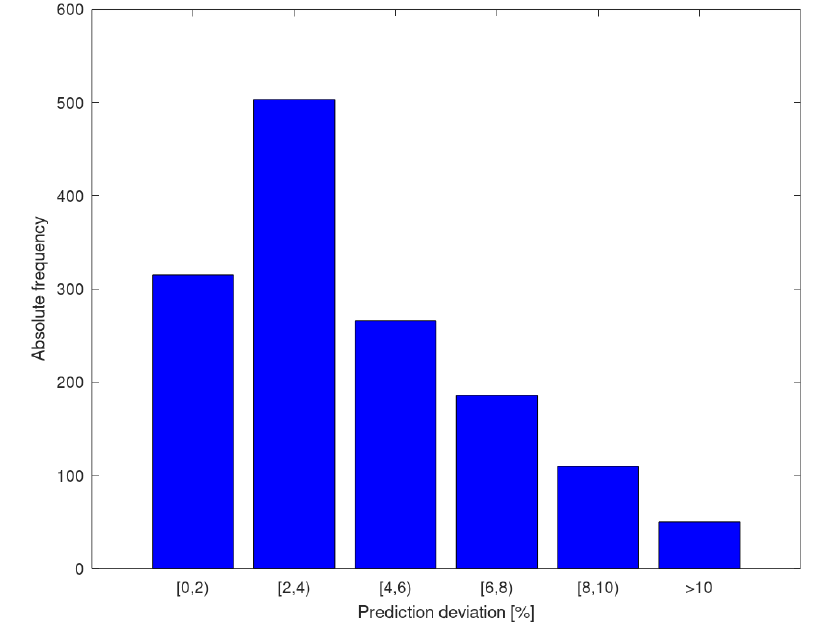
Figure 11. Histogram of the prediction error of the ultimate tensile strength for all